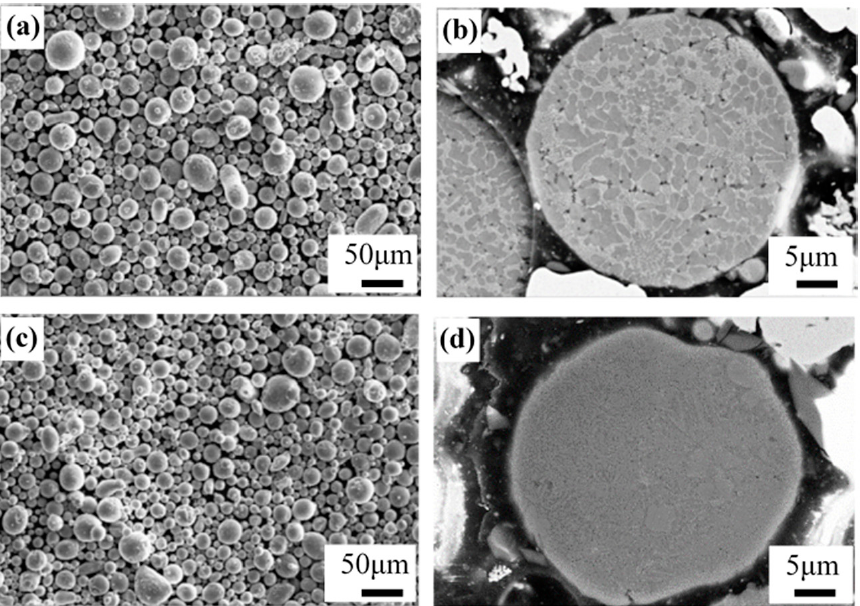
Figure 1. Microstructures of ( a , b ) Al–12Si, and ( c , d ) Al–20Si gas atomized powders.